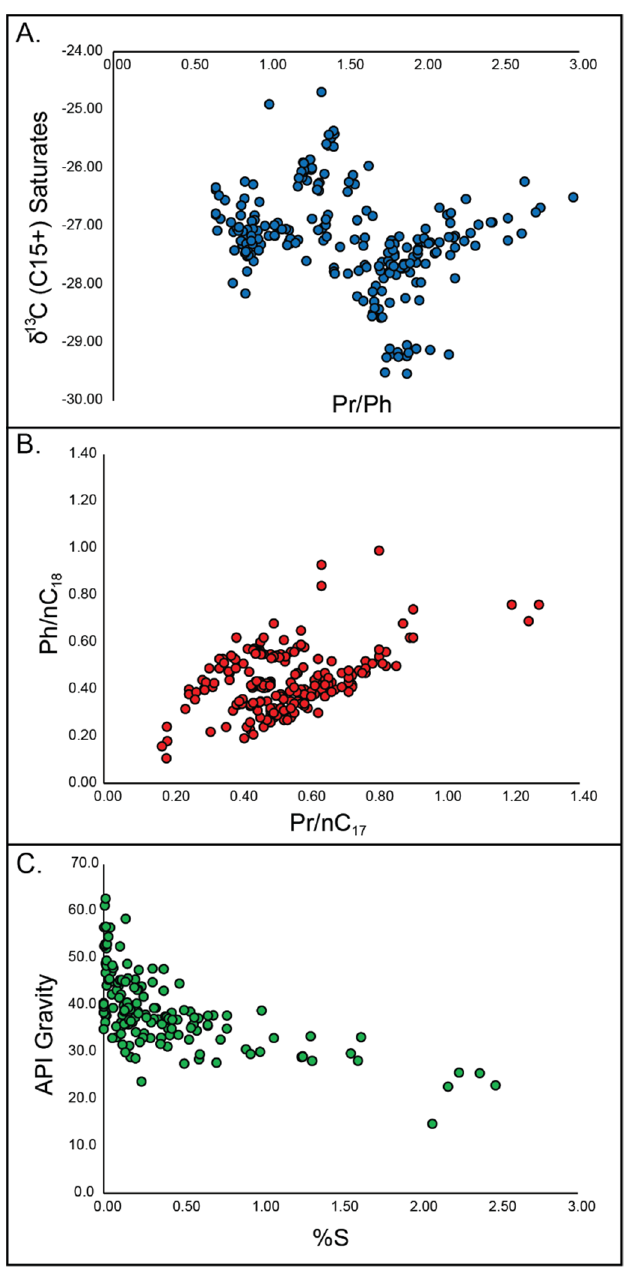
Figure 10. Bivariate cross-plots of the Upper Cretaceous Eagled Ford sourced oils identified in GeoMark’s OILS database. In addition to the organofacies variation in the Eagled Ford Shale itself, there is also significant thermal maturity variations across the play and potential for mixing with self-sourced fluids in the various reservoirs of the Eagle Ford. All of these factors play a role in the wide range of geochemical signatures across the play. ( A ) Carbon isotope signatures ( δ 13 C VPDB ) of the C15 + saturate relative to Pr / Ph ratio. ( B ) Pr / nC 17 relative to Ph / nC 18 . ( C ) API gravity (60 ◦ F) relative to weight %